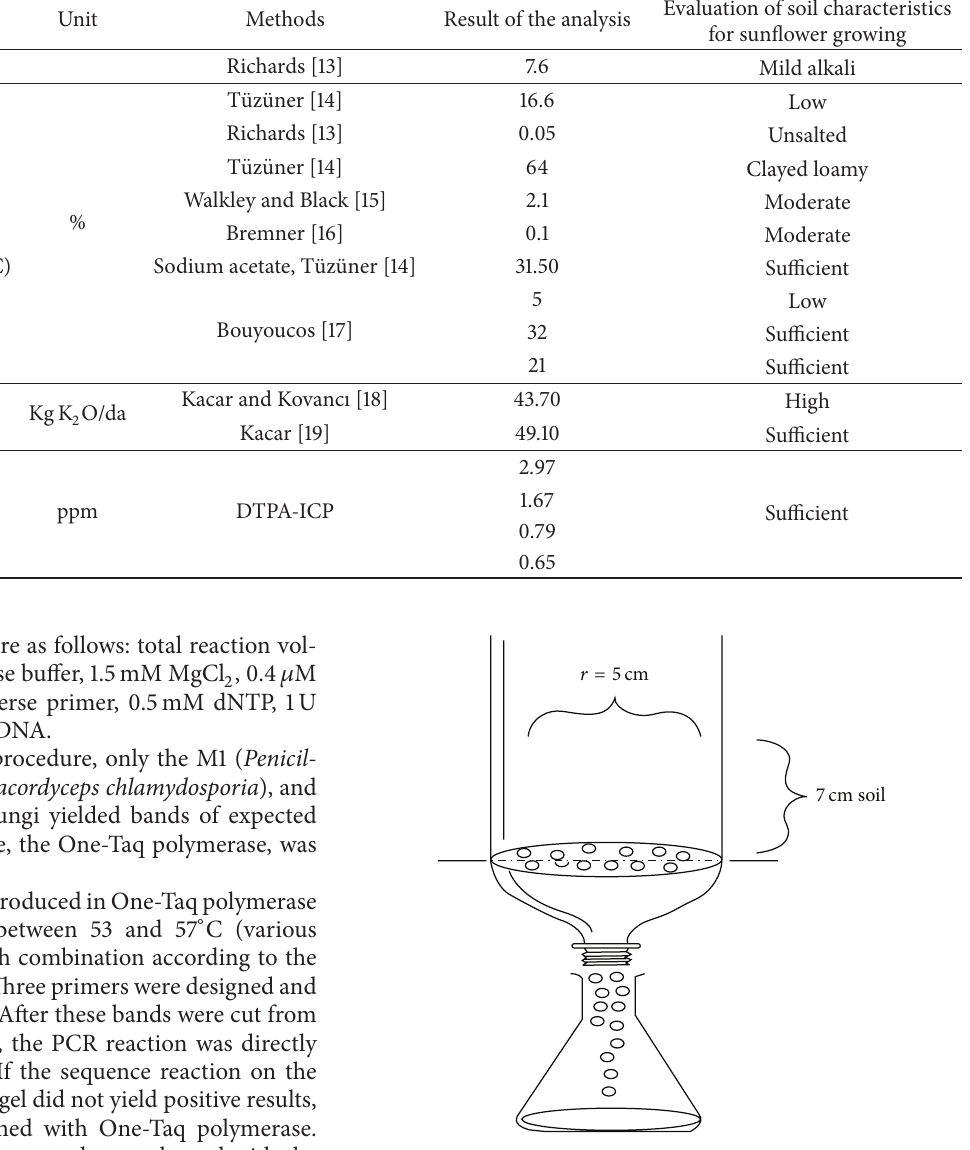
Figure 1: The soil